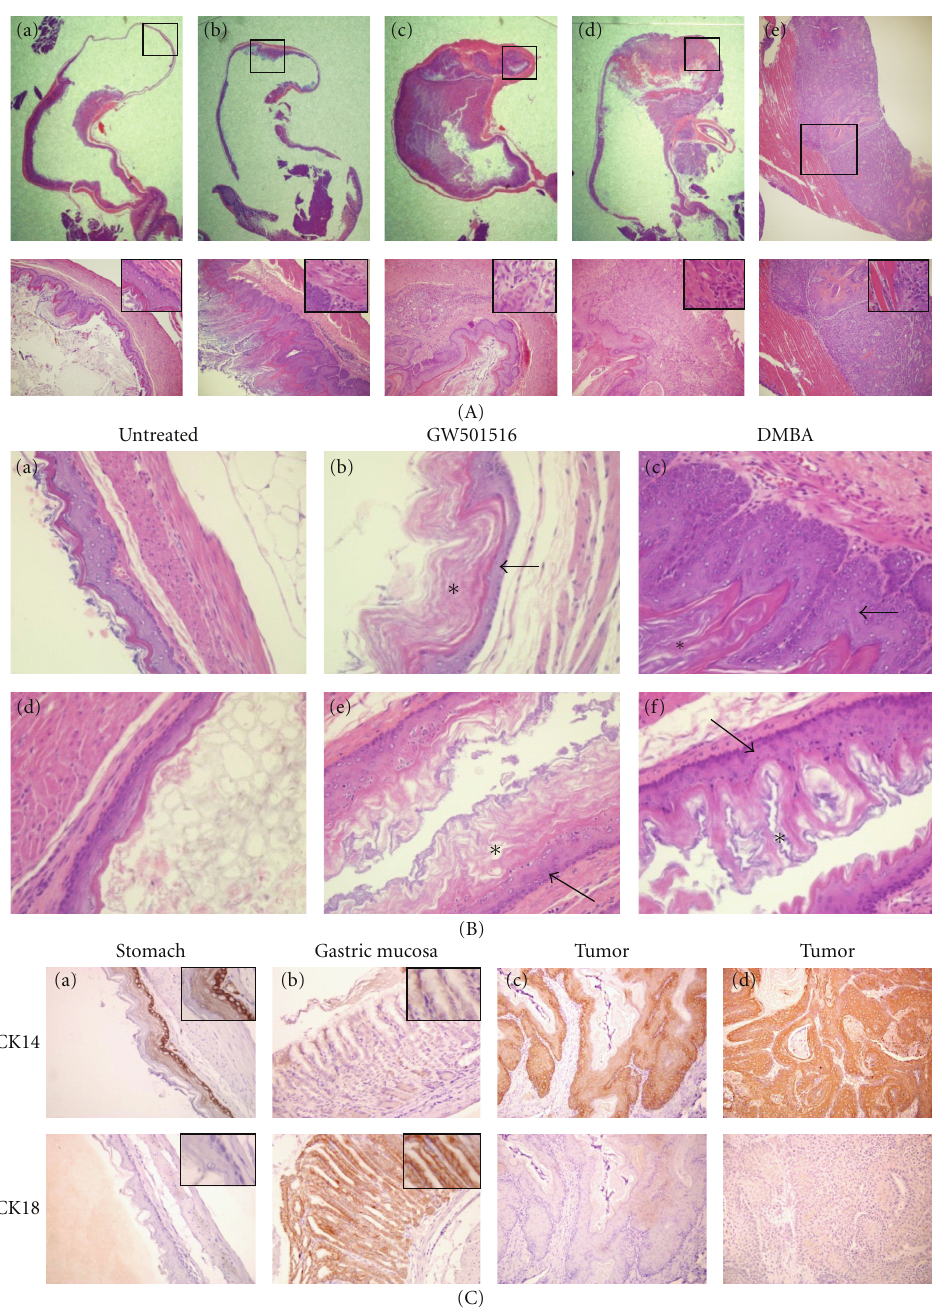
Figure 2: Pathophysiology of gastric tumorigenesis. (A) Histological changes in the forestomach after GW501516 and/or DMBA treatment. Upper panel: Stereoscopic images of H&E stained sections of the stomach in (a) untreated, (b) DMBA-treated, (c, d) DMBA plus GW501516- treated mice, and (e) metastases of the abdominal wall. Lower panel : higher magnification (200x) of the boxes in areas in the upper panel . Insets , magnification 400x. (a) Morphology of the normal forestomach wall. (b) Squamous epithelial hyperplasia, where the basal membrane is well defined. (c) Squamous cell carcinoma. (d) Invasive squamous cell carcinoma showing disruption of the basement membrane. (e) Metastatic squamous carcinoma showing invasion into the abdominal wall. (B) Histological changes in the stomach and esophagus after treatment with either GW501516 or DMBA. H&E sections of the forestomach wall (a, b, c) and esophagus (d, e, f) six months after administration of GW501516 or five months after treatment with DMBA. Both GW501516 and DMBA were associated with increased keratinization ( ∗ ) of squamous epithelium (arrow). Magnification 400x. (C) Cytokeratin 14 ( CK14 ) and cytokeratin18 ( CK18 ) expression in gastric tissue and tumors. Squamous epithelium of the forestomach (a), gastric mucosa (b), and gastric tumors (c, d). Tumors are CK14 + / CK18 − indicating a squamous epithelial origin. Magnification 200x, insets ,